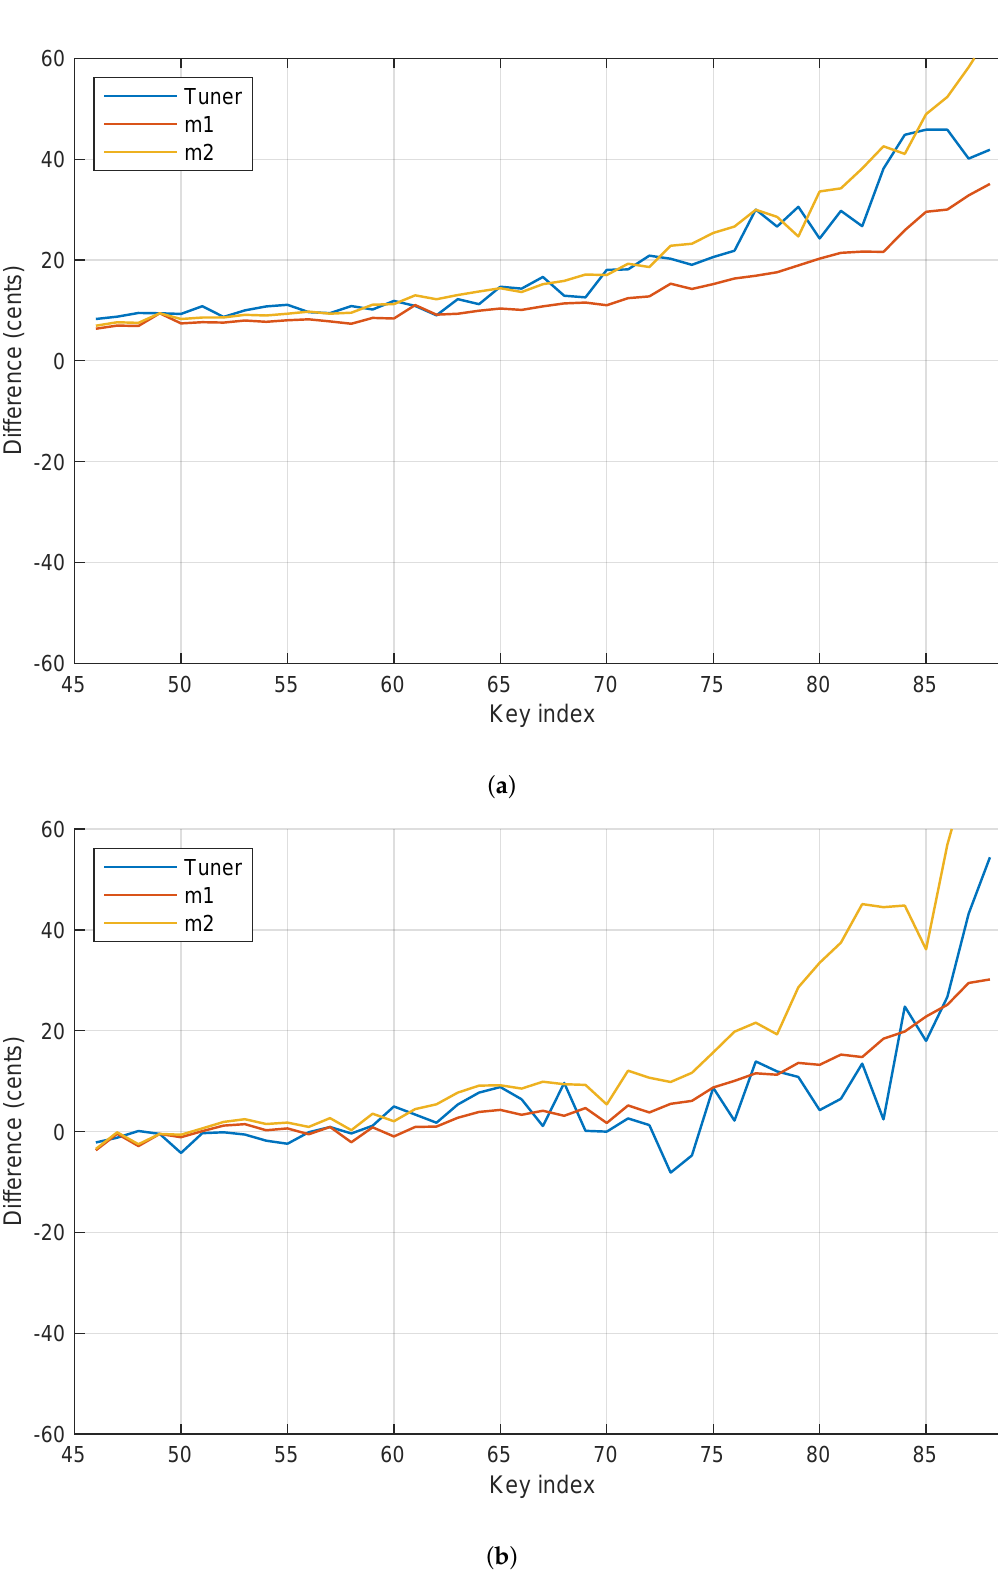
Figure 6. Railsback or tuning curves for two different sets of high piano tones: ( a ) set 1 tones and ( b ) set 2 tones. These were tuned by matching the first partial (m1) and the second partial (m2) of an octave and are compared here to the measured professional tuner’s